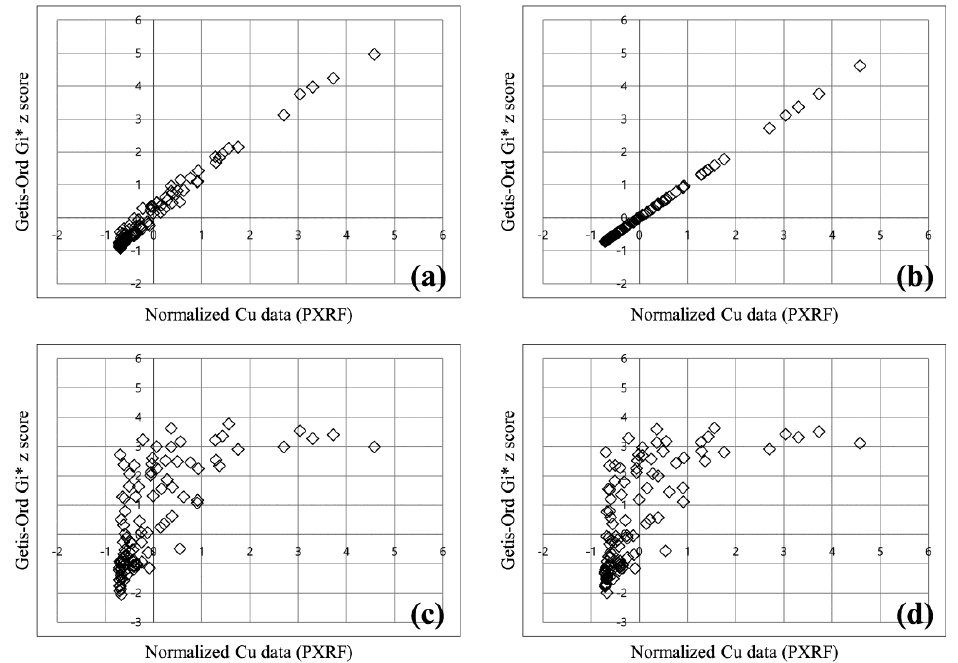
Figure 4. Scatter plots showing the relationship between a normalized copper concentration and Gi* z -score for different spatial relationship conceptualization methods: ( a ) Inverse distance method; ( b ) inverse distance squared method; ( c ) fixed distance method; and ( d ) zone of indifference method.